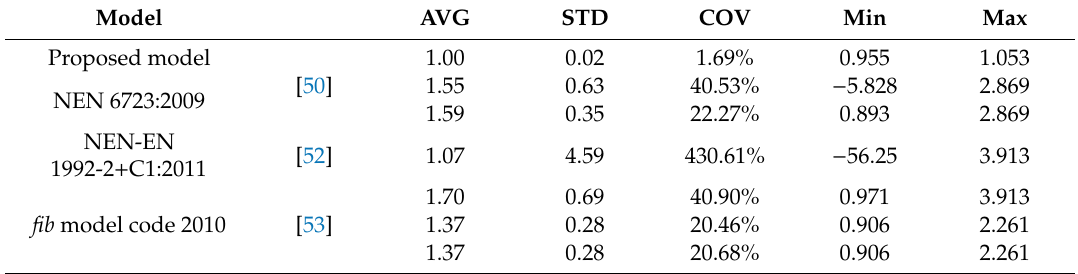
Table 5. Statistical properties of V utot / V pred for all datapoints with AVG = average of V utot / V pred , STD